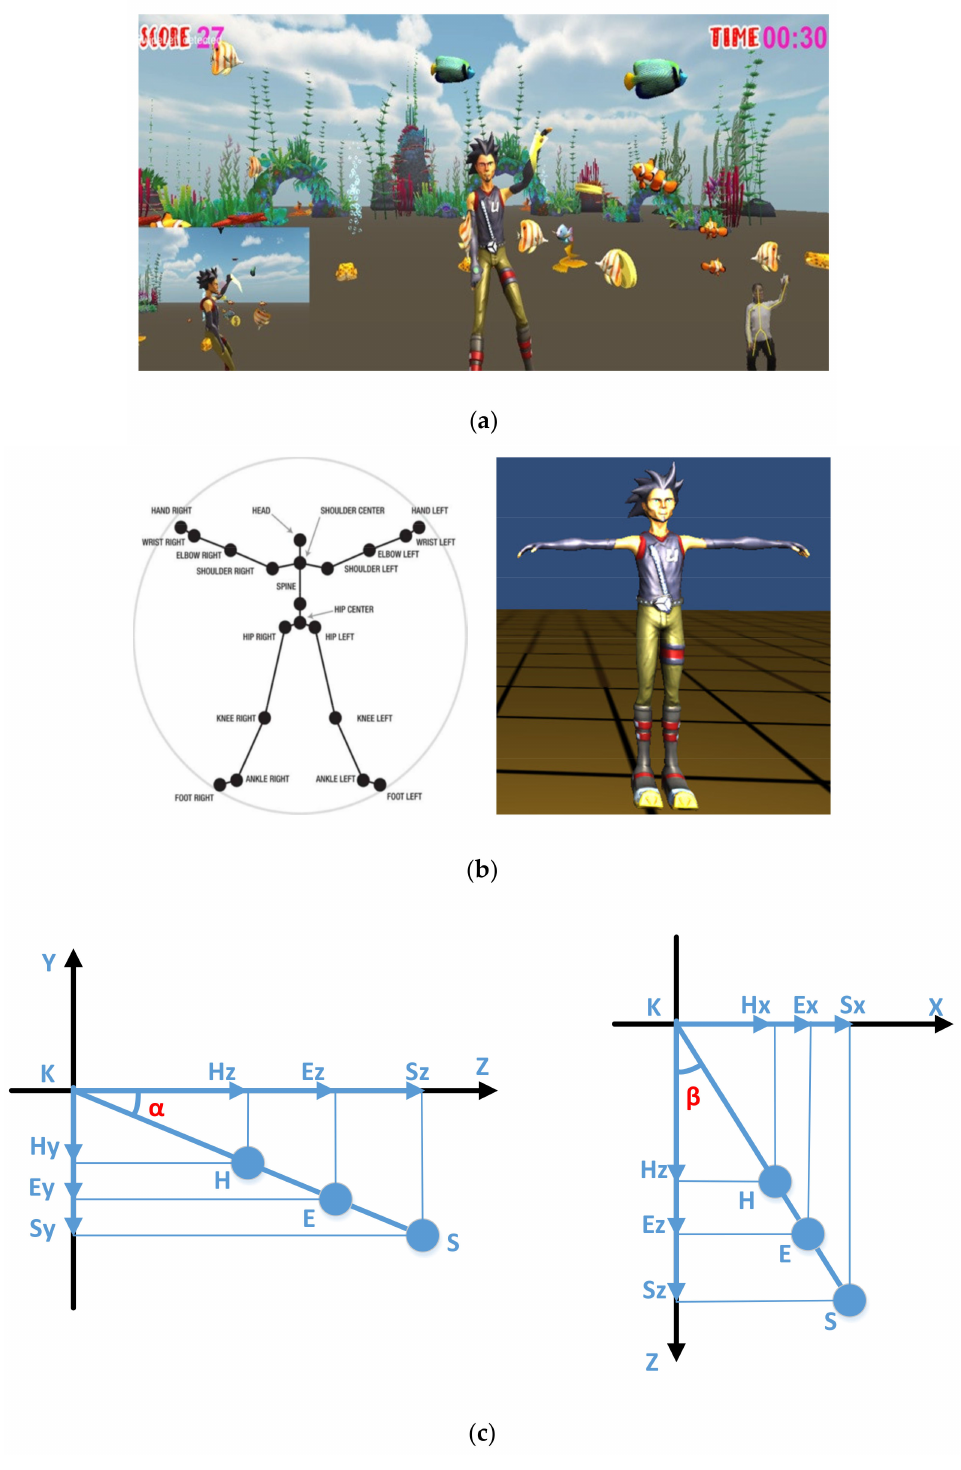
Figure 3. The 3-dimensional reachable workspace virtual game: ( a ) game scene, ( b ) skeleton-point binding, ( c ) occlusion